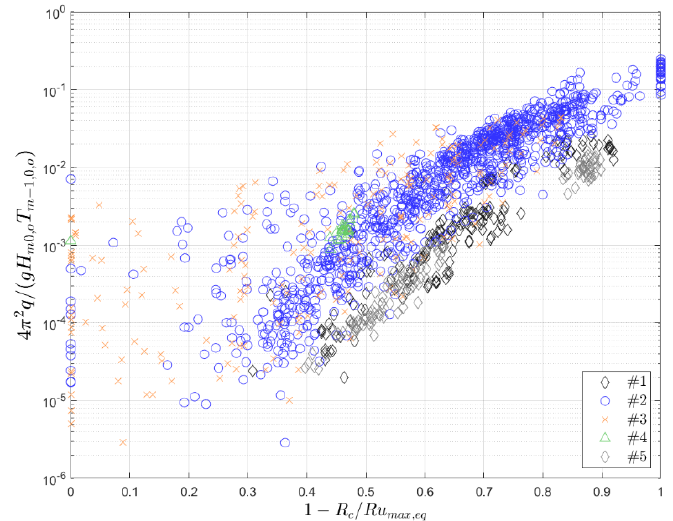
Figure 12. Dimensionless freeboard versus deficit in freeboard, where maximum run-up is calculated employing the formulas from EurOtop (2018) and the equivalent slope from Altomare et al. (2016).